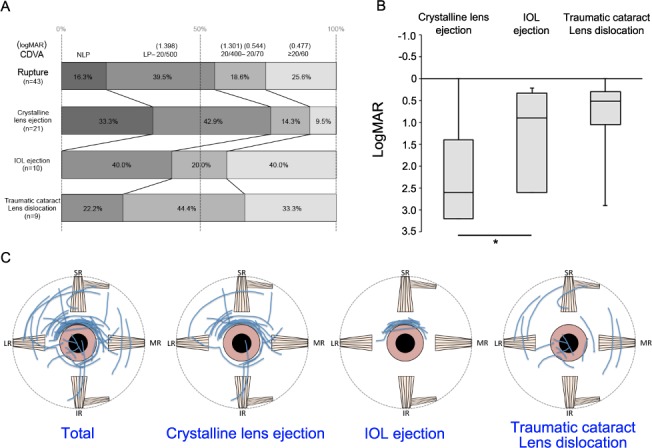
The difference in the final visual outcome depending on the lens damage.(A) More than 40% of the patients who had IOL ejection, traumatic cataract, or lens dislocation with ruptured ocular injuries showed a visual outcome of 20/400 or better. On the other hand, more than 70% of the patients with crystalline lens ejection had a visual outcome of 20/500 or worse. (B) A significantly better final visual outcome (logMAR) was attained in ruptured eyes complicated by IOL ejection than in those complicated by crystalline lens ejection. *P = 0.048. Error bars indicate whole range of distribution. (C) The wound patterns appeared to be different depending on whether the eyes had a crystalline lens (no history of cataract surgeries) or IOL (history of cataract surgeries). Among 43 ruptured eyes, the eyes complicated by crystalline lens ejection (n = 21) showed traumatic wounds at the corneoscleral limbus and deeper zone of the sclera. In contrast, the traumatic wounds of the eyes complicated by IOL ejection (n = 10) were mostly located only around the corneoscleral limbus. The wounds of the ruptured eyes complicated by traumatic cataract and lens dislocation (no lens/IOL ejection, n = 9) were not located around the corneoscleral limbus. Wounds in the left eyes were projected as a mirror image and sketched on the right eye. IOL, intraocular lens; logMAR, logarithm of the minimum angle of resolution.